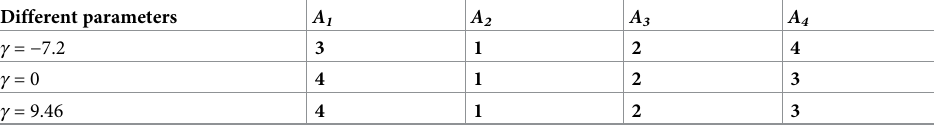
Table 6. A comparison of the orders of the alternatives of Example 1 for different parameters. Different parameters